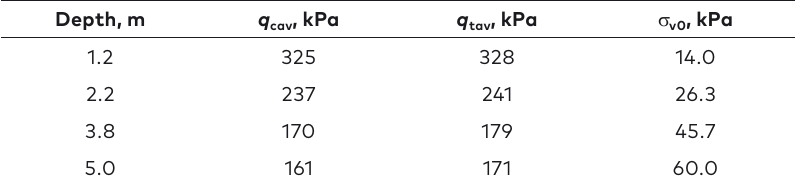
Table 5. Cone resistances and the total stresses at considered depths